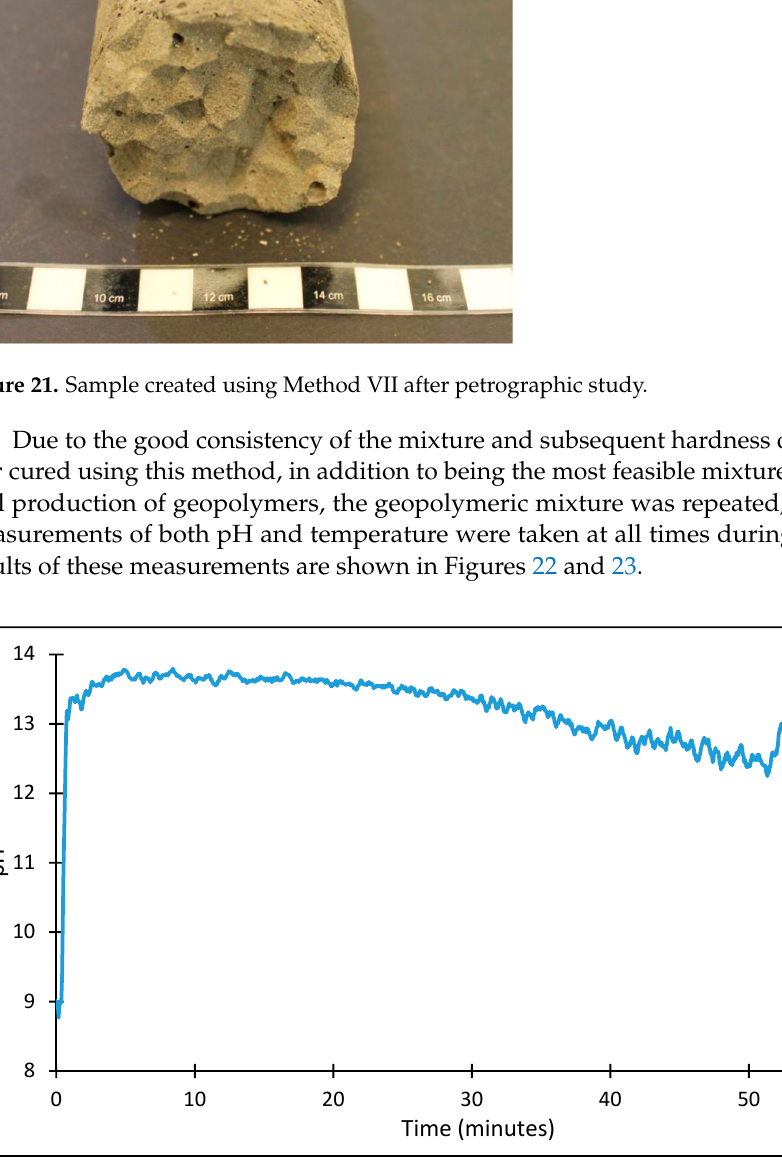
Figure 20. Consistency of Method VII, 7 days at 90 °C.